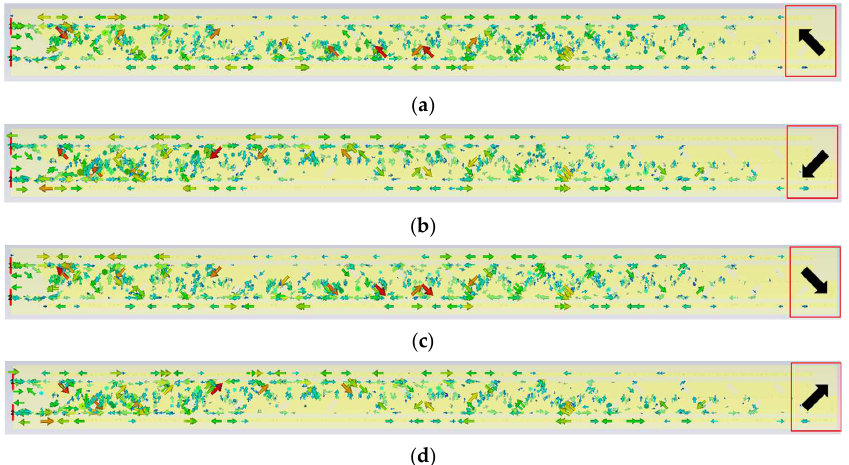
Figure 5. Surface current distributions with different phases for LHCP: ( a ) 0°, ( b ) 90°, ( c ) 180°, and ( d ) 270°.